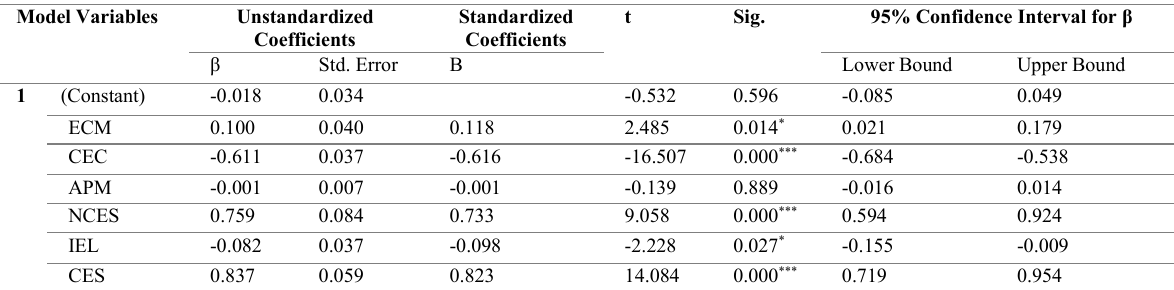
Table 3: Analysis of Regression Coefficients